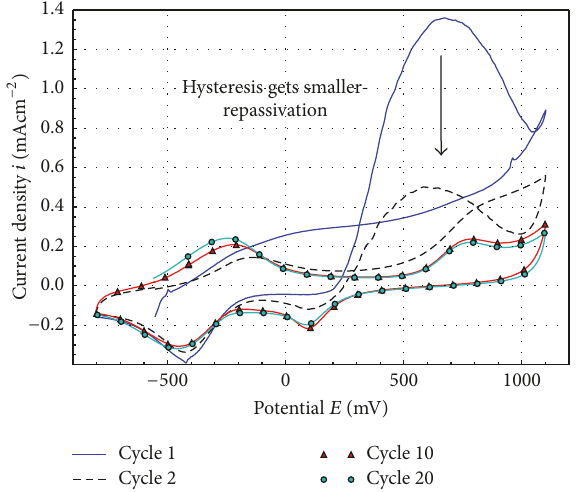
Figure 5: Cyclic voltammogram of AISI 304 in phosphate buffer with 0.3 wt.% NaCl. The scans are recorded from − 800 mV to 1100mV with a scan velocity of 100mVs −1 . All potentials are measured against a Ag/AgCl electrode.